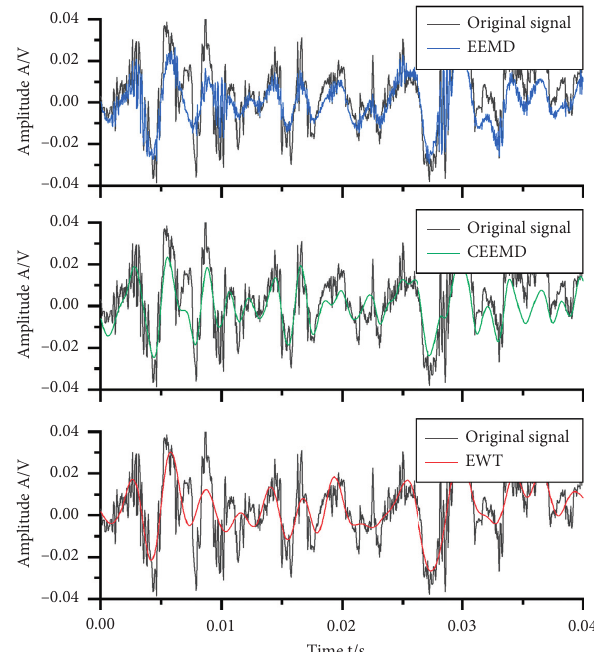
Figure 13: Comparison of denoising effects of three different denoising methods.